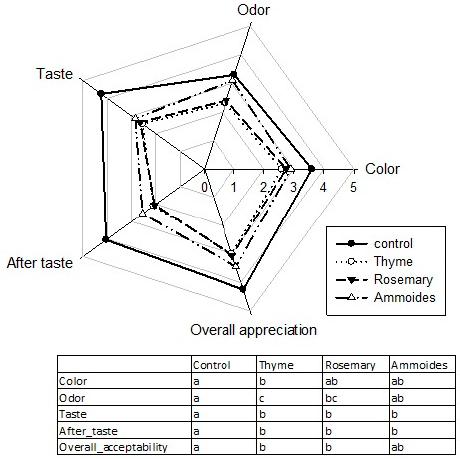
Figure 4. Radar chart for sensory evaluation of pasteurized milk samples. Samples: control, aqueous extracts supplemented pasteurized milk at 0.5 mg/mL (thyme, rosemary, and ammoides). The attached table represents the significance letters resulting from a Tukey’s post hoc test.